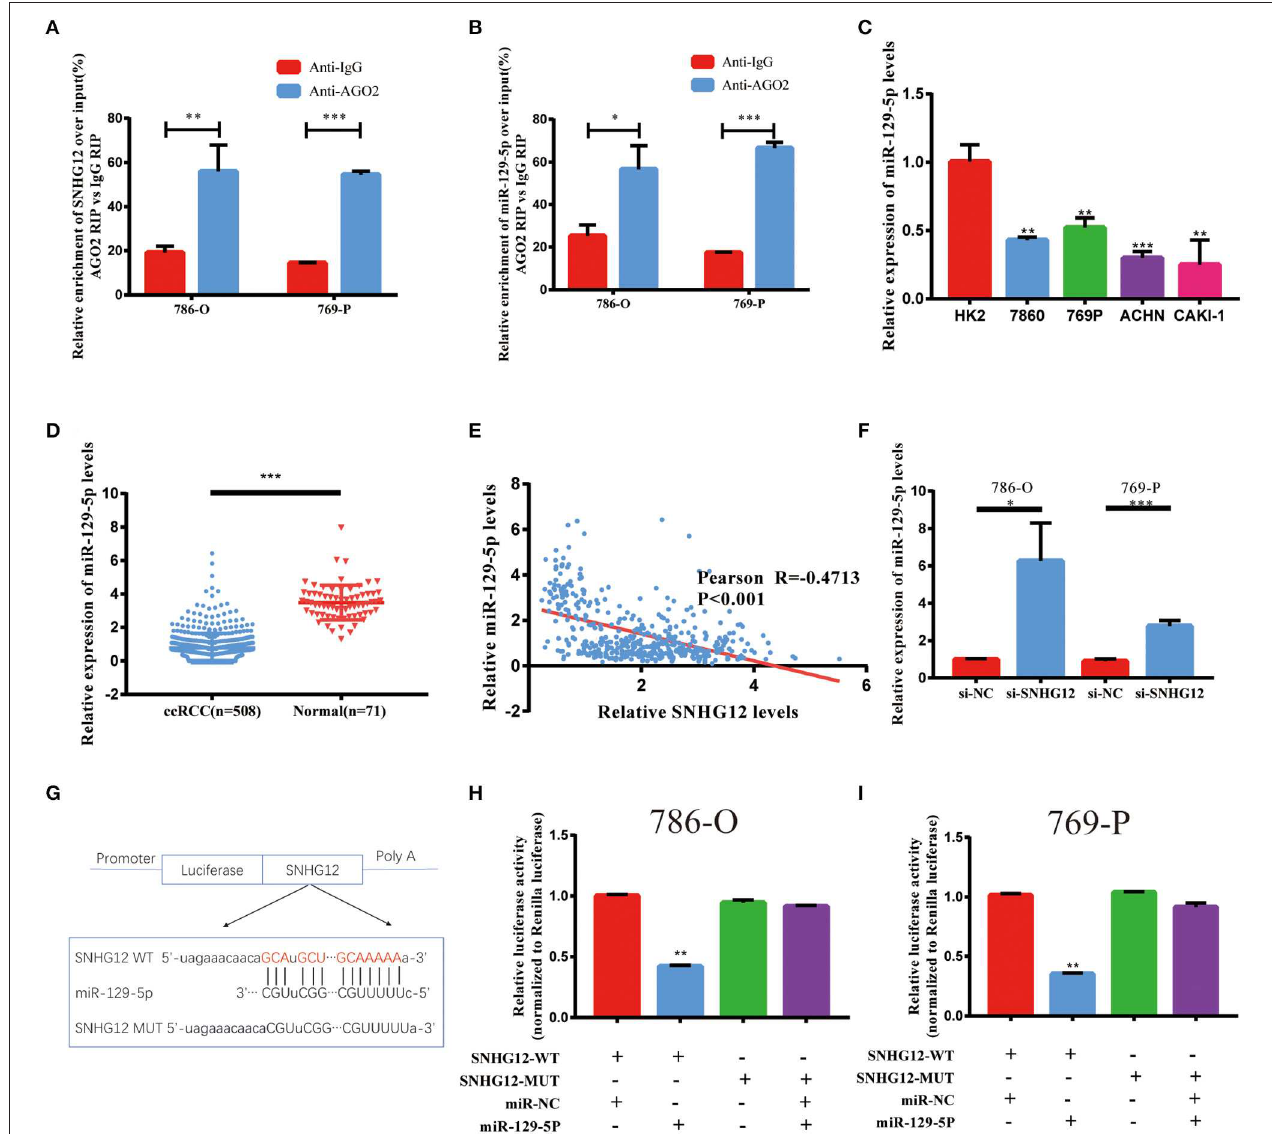
FIGURE 5 | Regulation relationship between SNHG12 and miR-129-5p. (A) RNA immunoprecipitation (RIP) experiments for SNHG12 in 786-O and 769-P cell lines. (B) RIP experiments for miR-129-5p in 786-O and 769-P cell lines. (C) QRT-PCR analysis of miR-129-5p expression in different cell lines. (D) Relative expression of miR-129-5p in ccRCC tissues compared with normal tissues was analyzed using TCGA data. (E) Pearson correlation analysis between SNHG12 and miR-129-5p expression levels using data of ccRCC patients from TCGA. (F) QRT-PCR analysis of miR-129-5p expression in 786-O and 769-P cell linestransfected with si-NC and si-SNHG12. (G) Predicted binding site of miR-129-5p in SNHG12 using LncBase Predicted v.2. (H,I) Luciferase reporter plasmid containing wild-type (WT)786-O and 769-P cell lines or mutant (Mut) SNHG12 were co-transfected into cells with miR-129-5p in parallel with an empty plasmid vector.Values represent the mean ± SD of three independent experiments.* P < 0.05; ** P < 0.01; *** P <